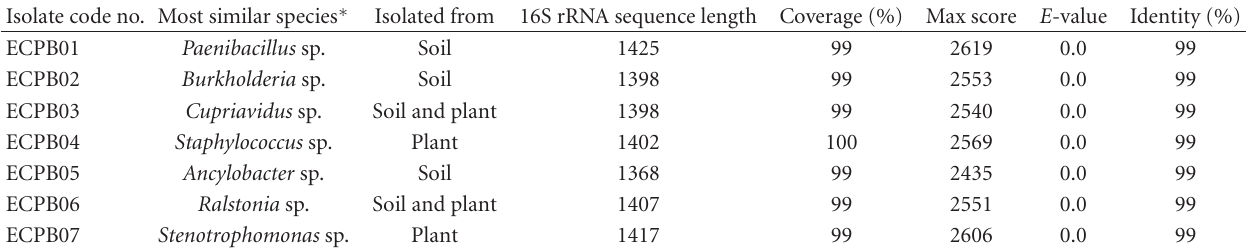
Table 1: Results of BLAST for the 16S rRNA sequences obtained from bacteria isolated from soil and plants samples. Isolate code no. Most similar species ∗